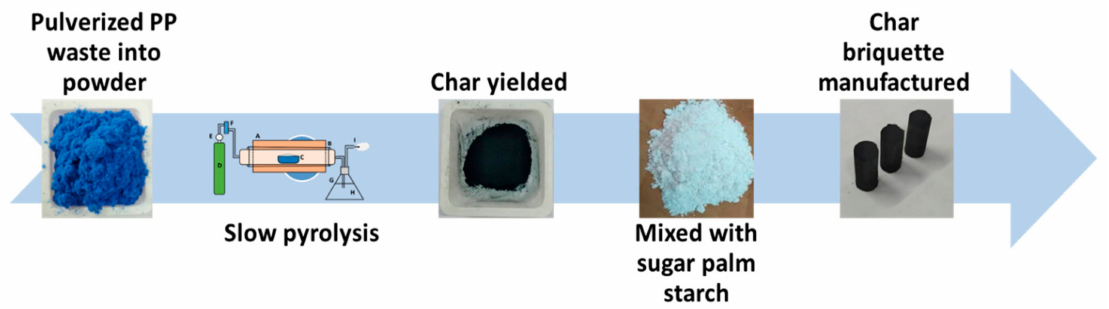
Figure 2. Flow of the process of manufacturing char briquettes